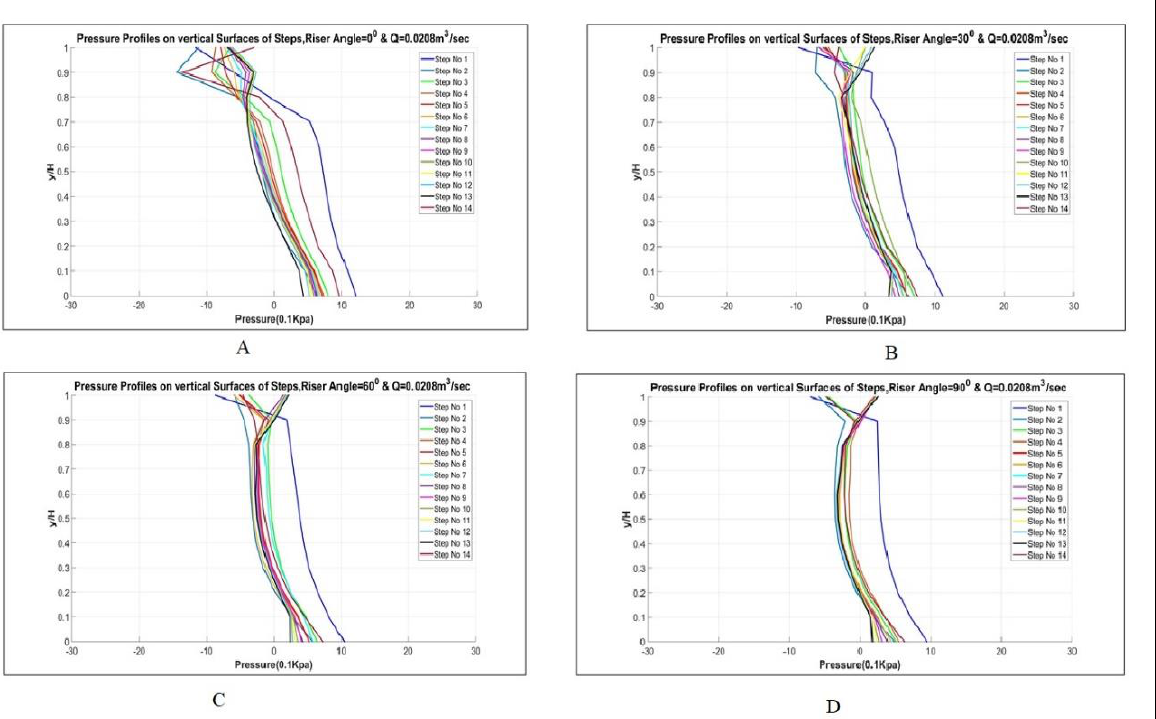
Figure 10. Pressure profiles for ( A ) simple stepped, ( B ) 30°, ( C ) 60°, and ( D ) 90° curved risers spillway for the head of 120 mm.